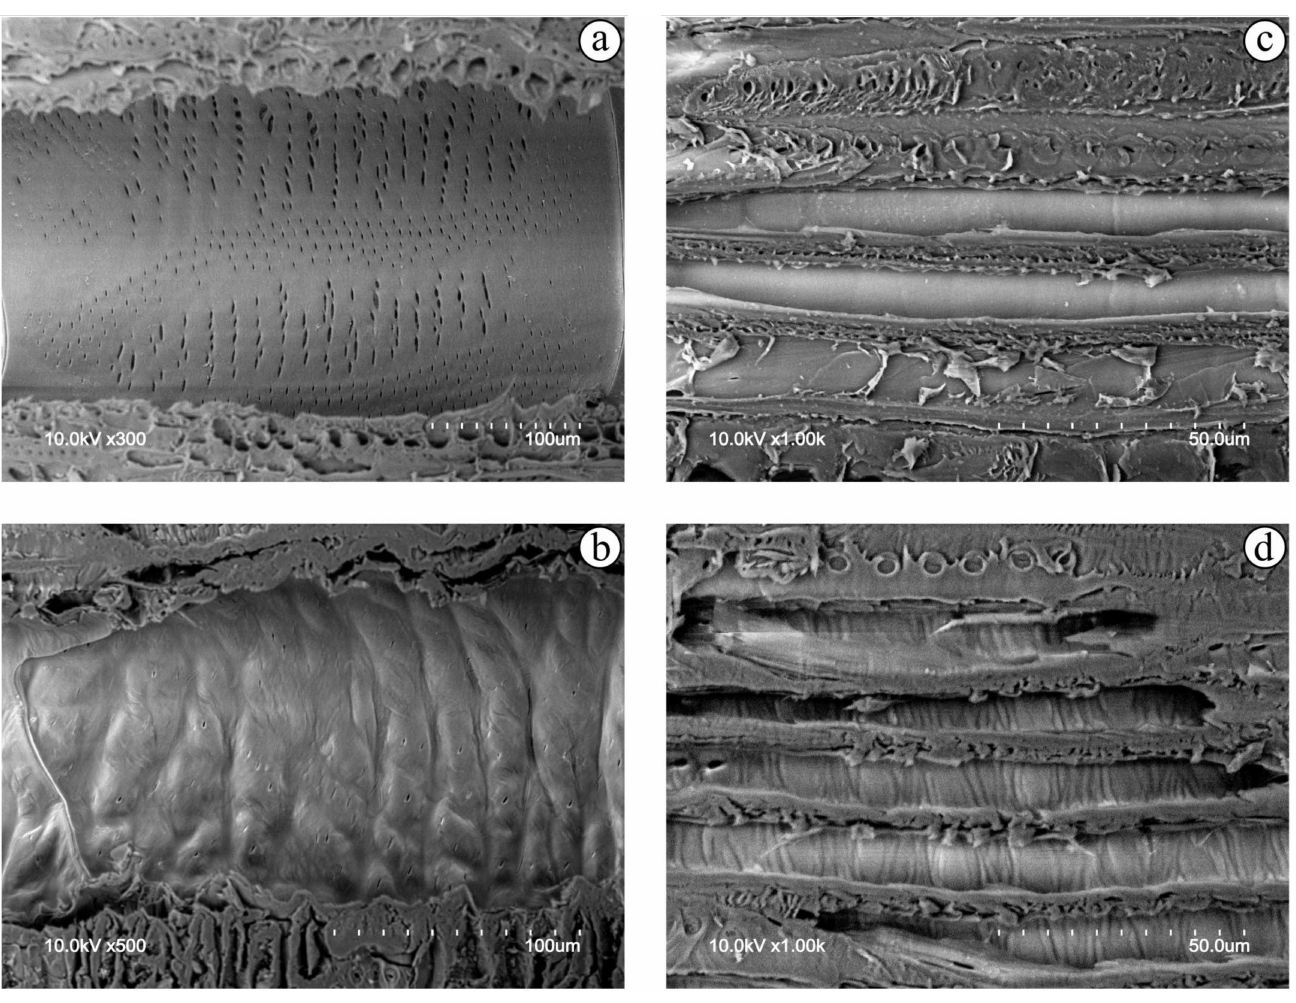
Figure 15. Scanning electron microscopy images of oak wood. ( a ) Untreated trachea (10 kV × 300); ( b ) pleated trachea (10 kV × 500); ( c ) untreated fibres (10 kV × 1000); ( d ) pleated fibres (10 kV × 1000). Reproduced from [9], with permission from Pulp and Paper Research Institute,